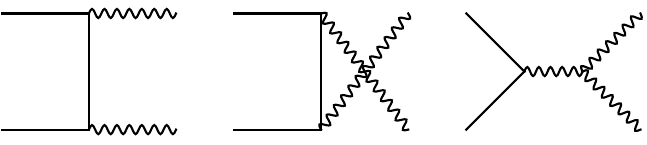
Figure 2 . Feynman diagrams in the fundamental theory for the annihilation of a wino pair into electroweak gauge bosons at order (cid:11) 2 . If M is su(cid:14)ciently large and the winos are nonrelativistic, the ladder diagrams from the exchange of electroweak gauge bosons between the incoming wino lines must be summed to all